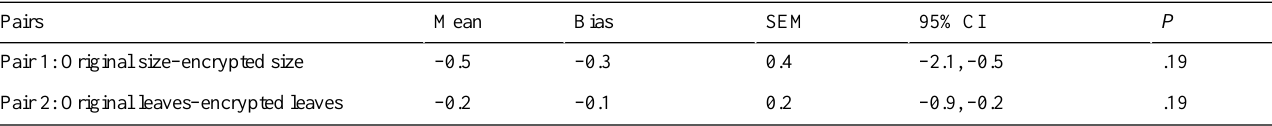
Table 3. Bootstrapped paired samples test